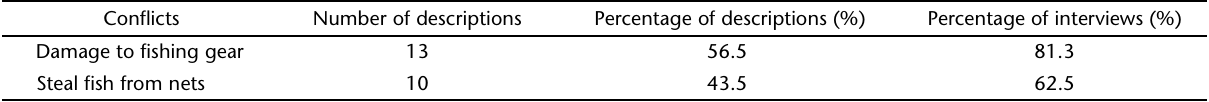
Table II. Conflicts between Inia geoffrensis and fishery.